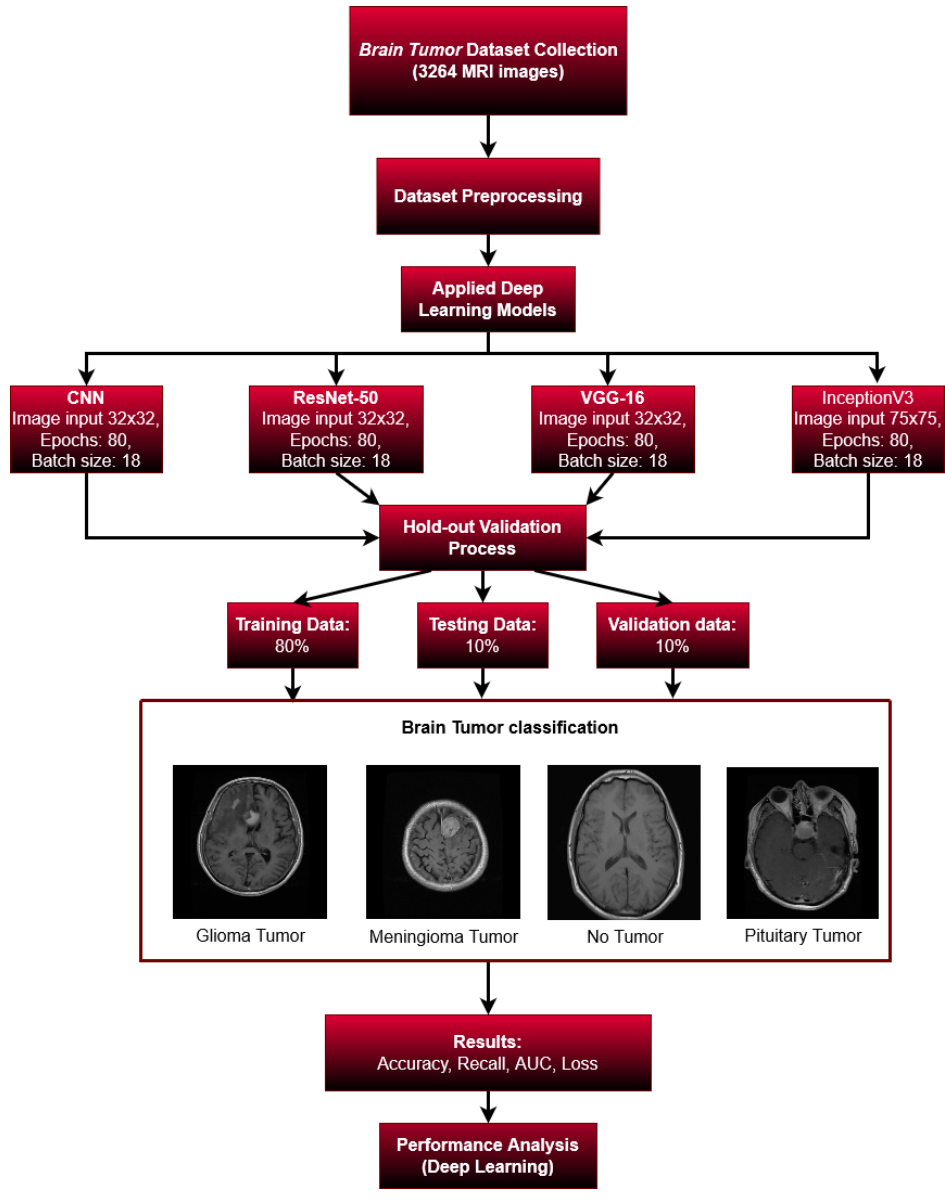
Figure 3. Overall Study. Table 2.